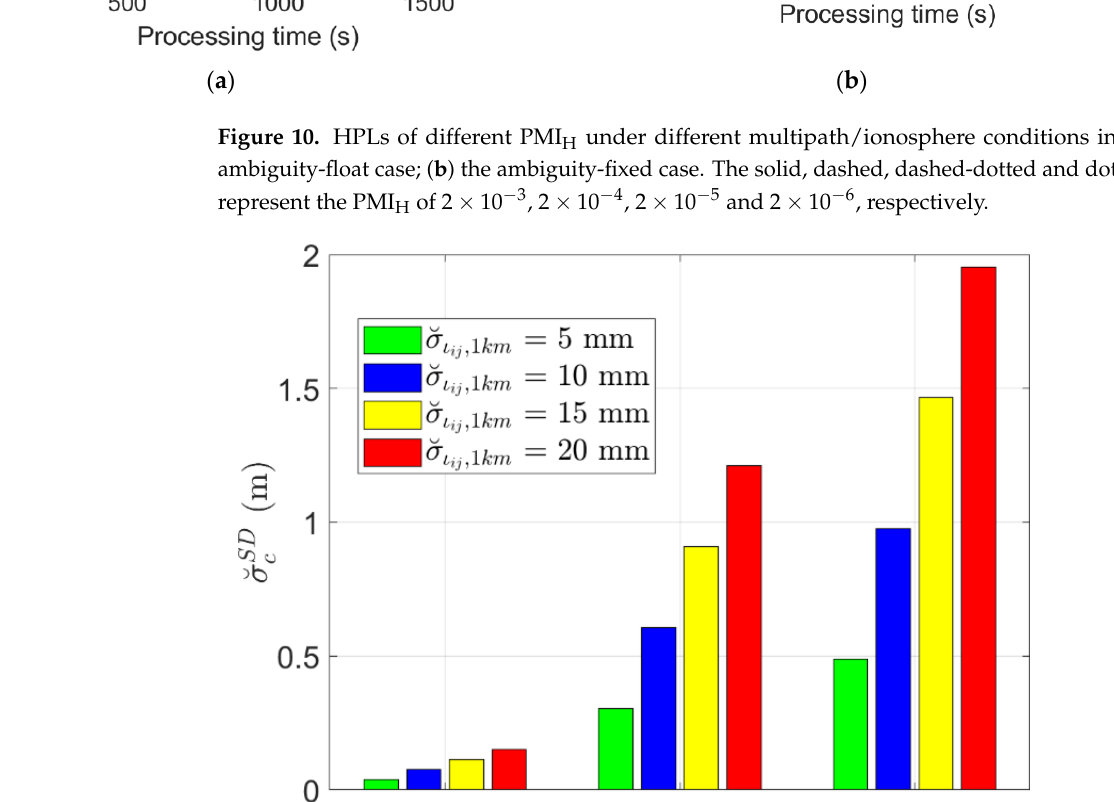
Figure 11. Overbounding standard deviations of the between-satellite network corrections for the satellite pair C26 and C29 at the end of a half-hour session.